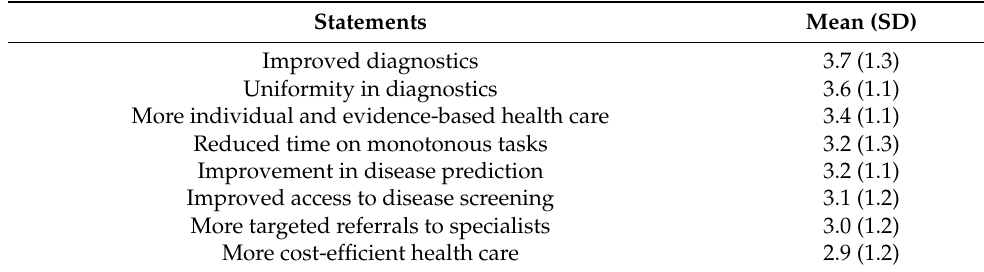
Table 2. The advantages of AI in dentistry according to 302 dentists rated on a 5-point Likert scale. 1: low relevance; 5: high relevance.